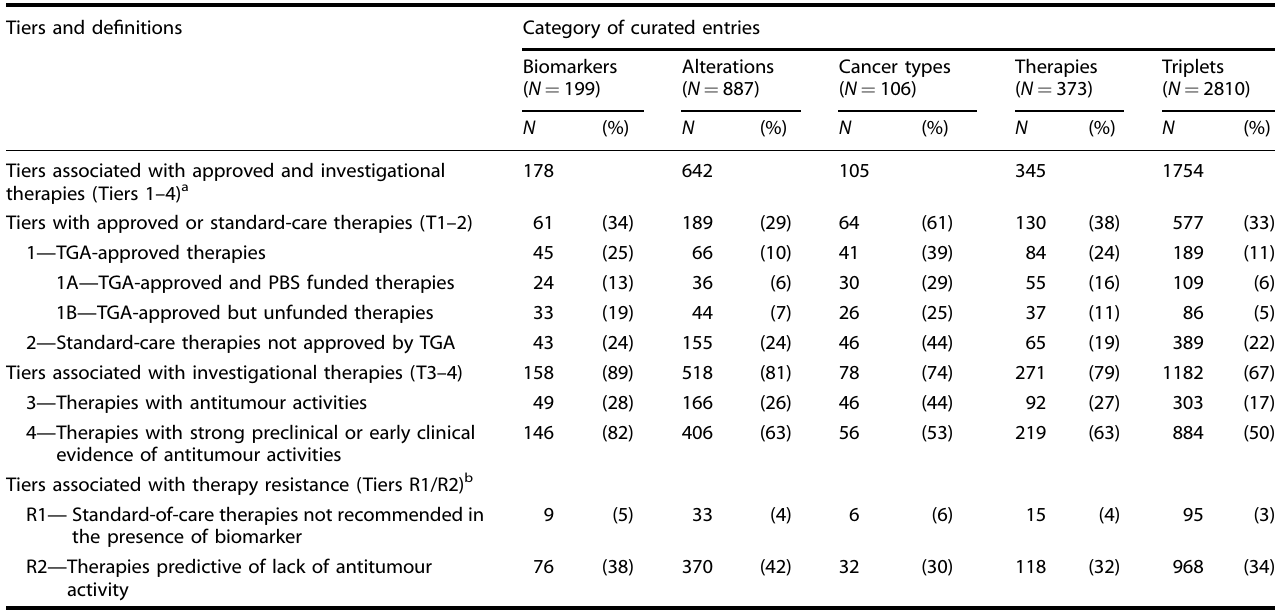
Table 1. Summary of biomarkers and therapies curated in TOPOGRAPH by